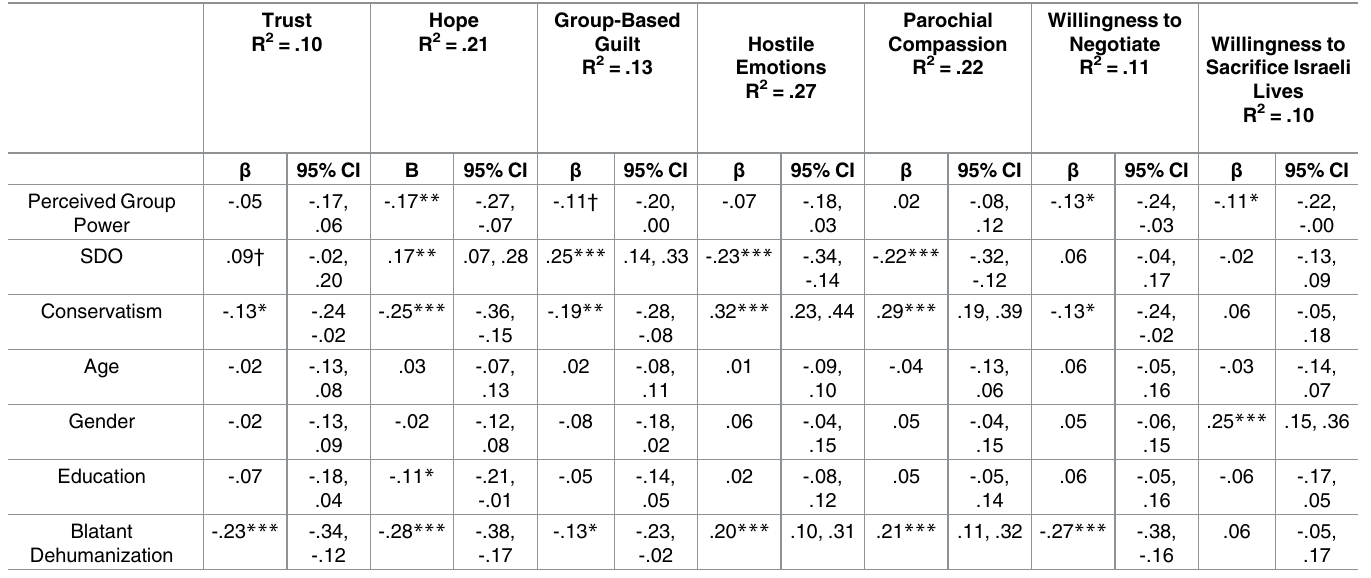
Table 4. Simultaneous regressions predicting outgroup attitudes as a function of political ideology and dehumanization in Study 2. Trust R 2 =